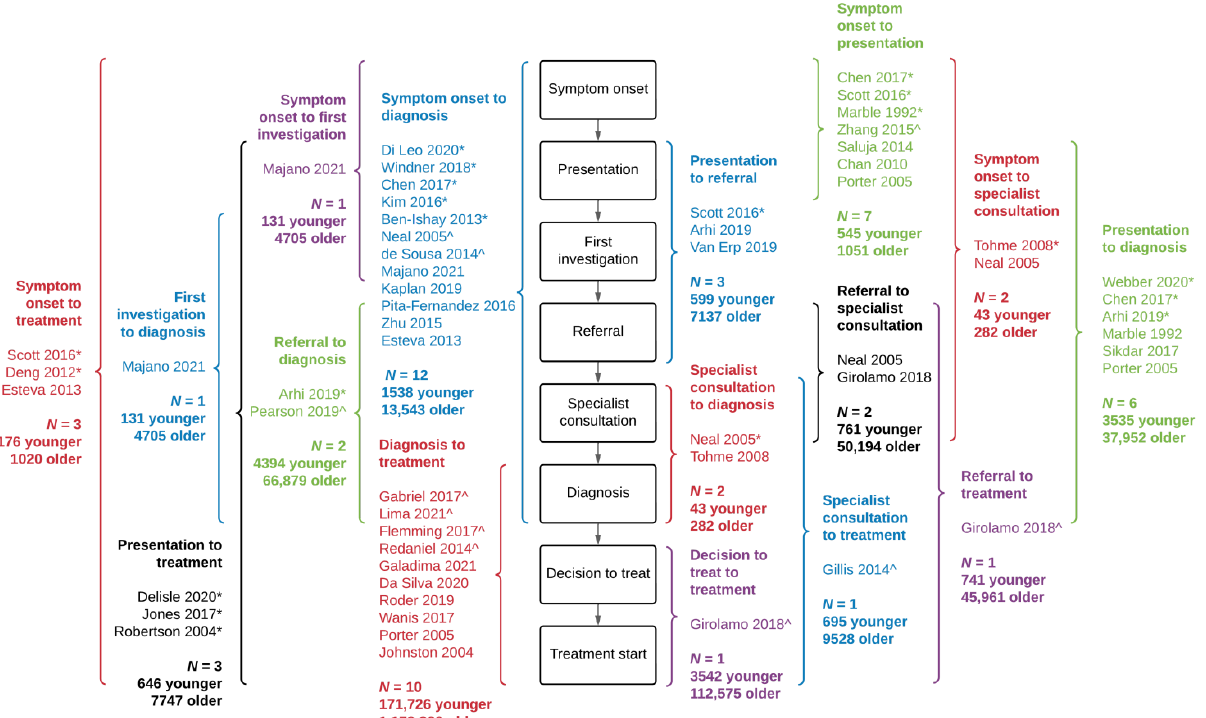
Figure 2. Reported comparisons of delay intervals between younger and older adults with colorectal cancer, grouped by interval on the pathway to treatment. Shown is the number of studies in each interval, and the sample size of younger and older adults. Studies that did not report sample sizes for both younger and older are not included in the number of patients. *Indicates study found significantly longer delay among younger adults with colorectal cancer and ^indicates study found significantly shorter delay among younger adults.